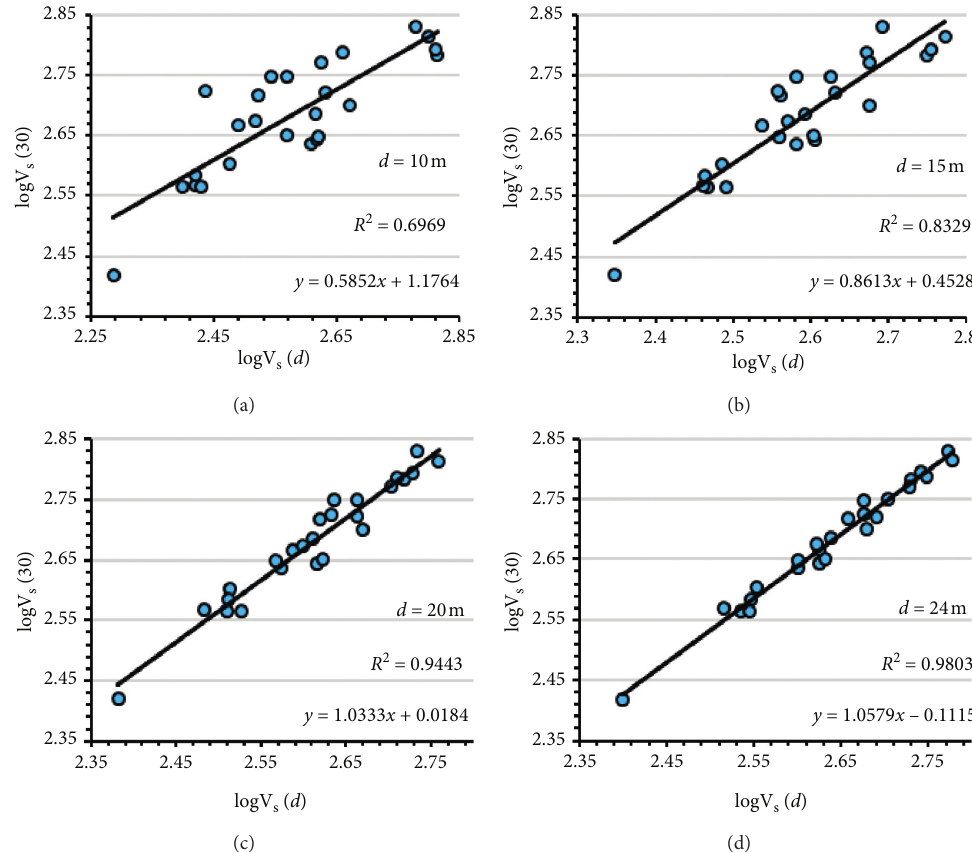
Figure 5: log ( V S 30 ) as a function of log ( V Sd ), for d